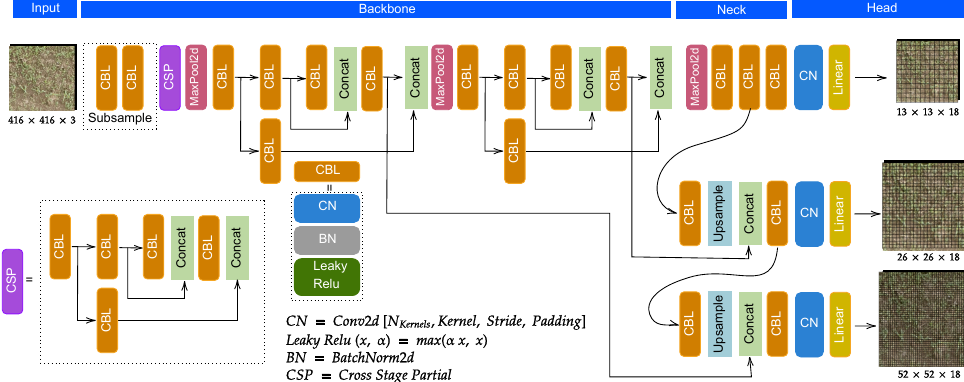
Figure 6. Diagram of the YOLOv4-tiny-3l architecture with an input image of 416 × 416 pixels and 3 channels.